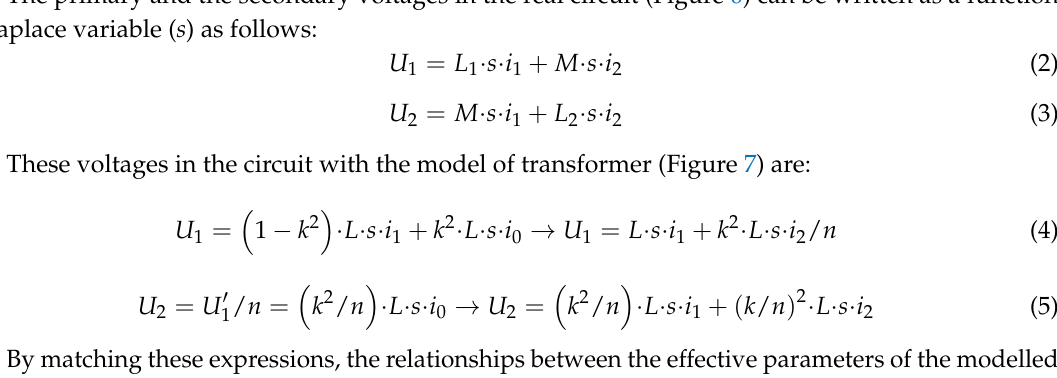
Figure 7. Electric equivalent circuit of wireless temperature sensor with a modelled transformer.